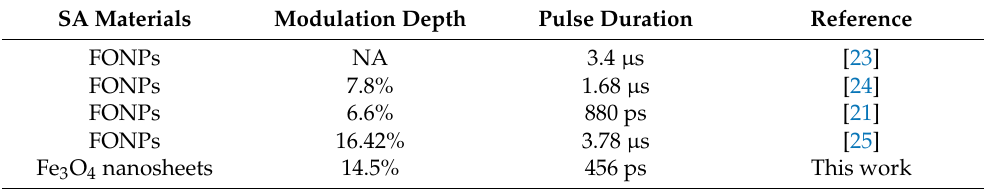
Figure 10. Average output power and single pulse energy with pump power. In the figure, the CW is in continuous wave, and ML is mode-locked. Table 1. Performance comparison of YDFL based on magnetic fluid as